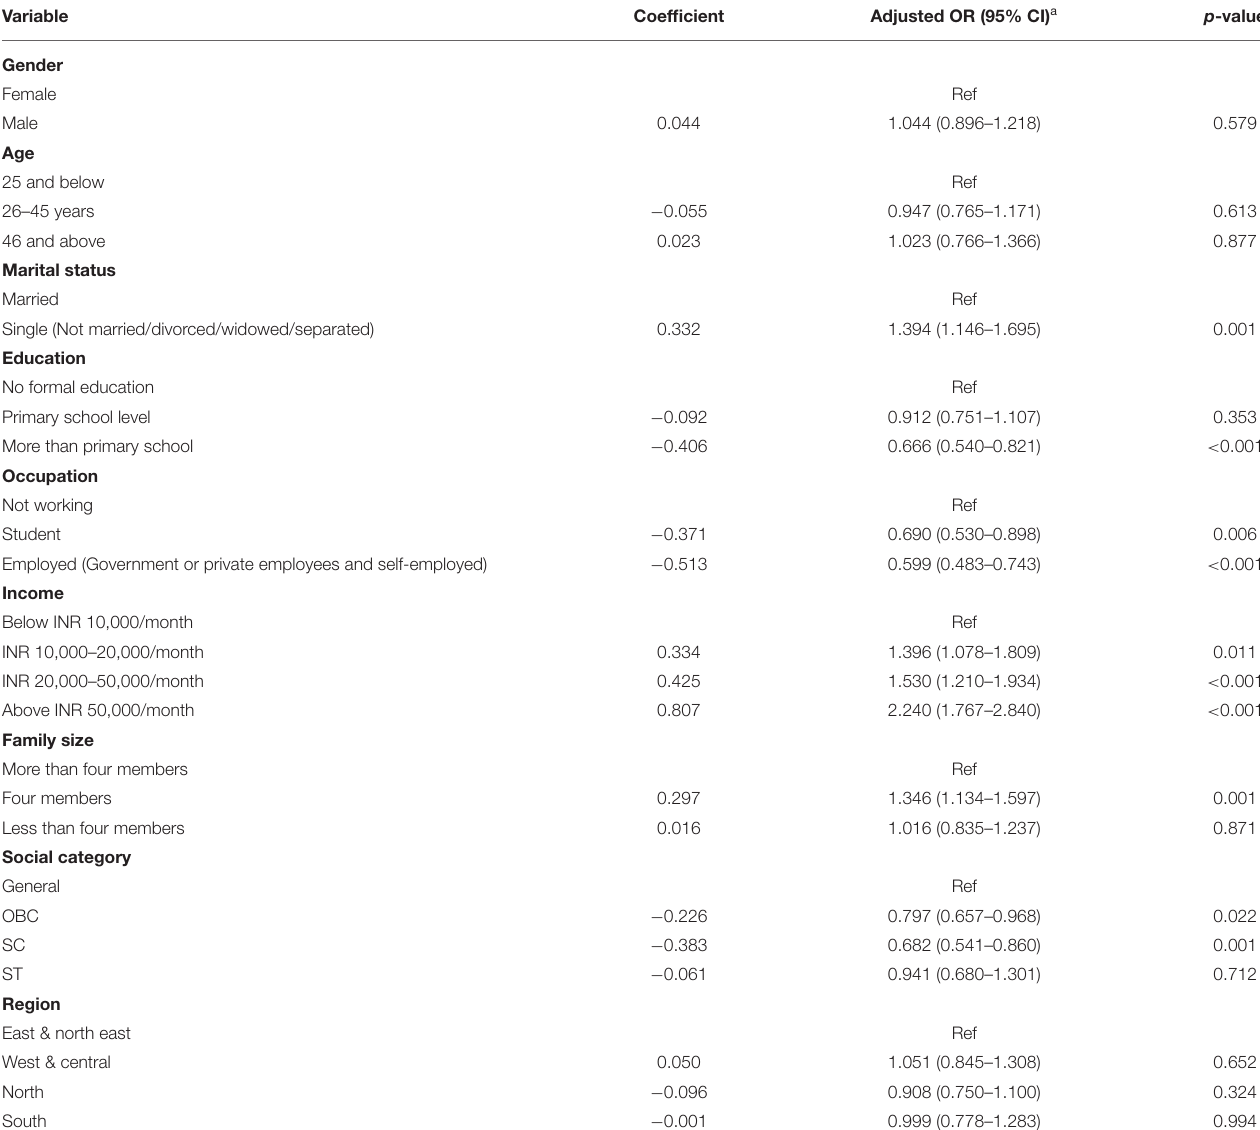
TABLE 3 | Association between the sociodemographic variables and willingness to pay ( n = 3,341) using the multivariate binary logistic regression analysis.